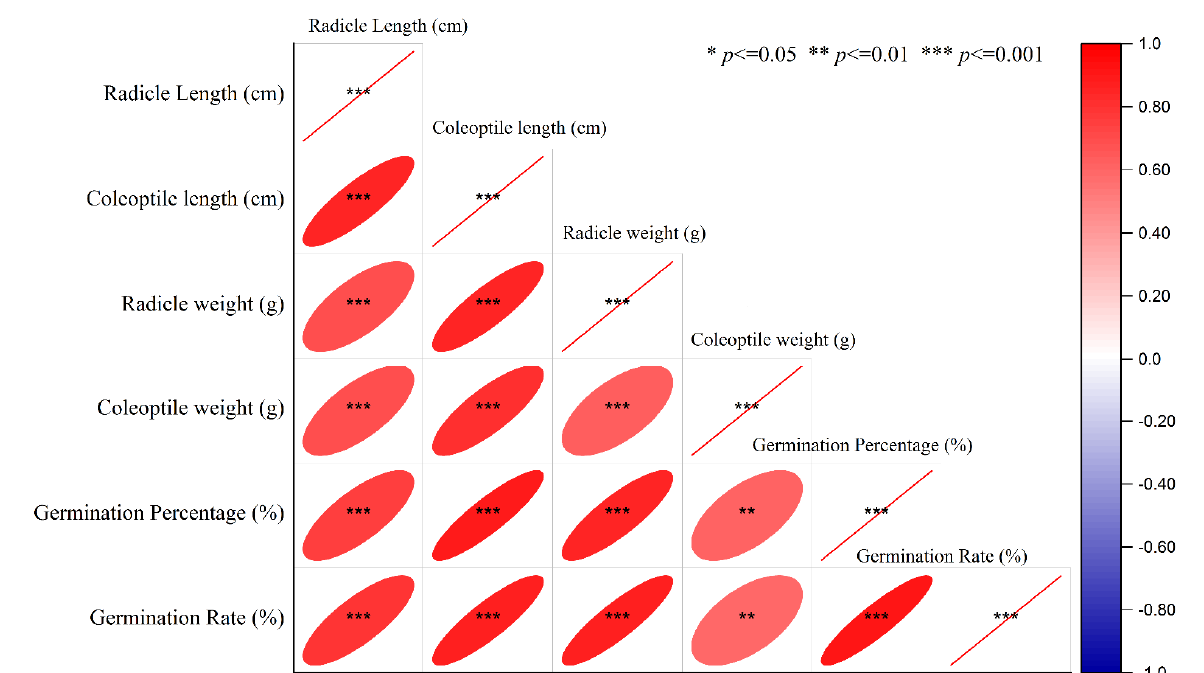
Figure 7. Pearson correlation between germination characteristics in wheat varieties.